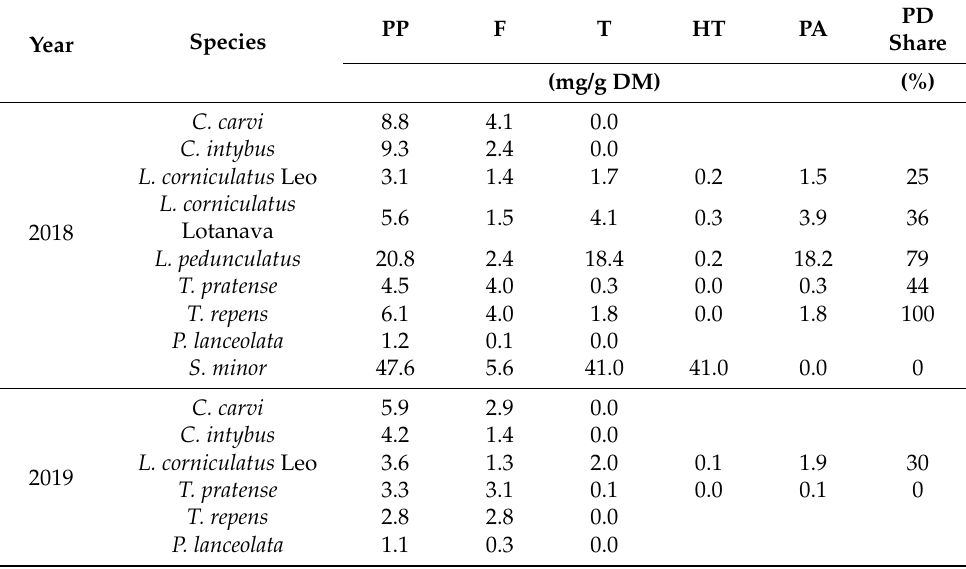
Table 3. Tannin composition (mg/g DM) of the species evaluated, harvested in 2018 and 2019. (polyphenols (PP), flavonols (F), tannins (T), hydrolyzable tannins (HT), proanthocyanidins (PA), prodephinidins